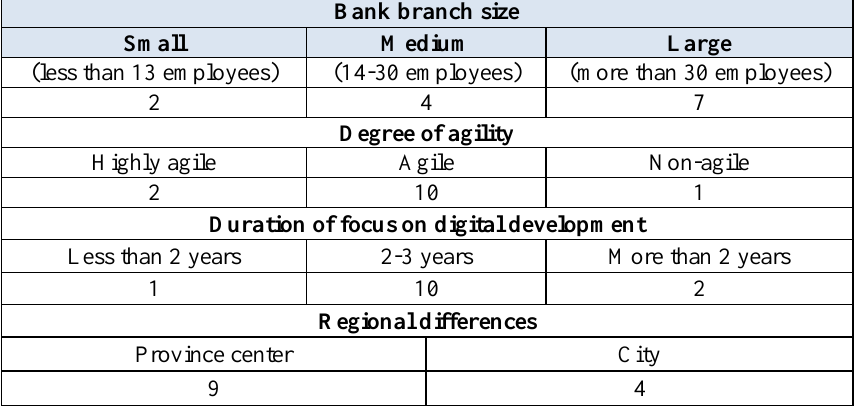
Table 4. Characteristics of the bank branches and control